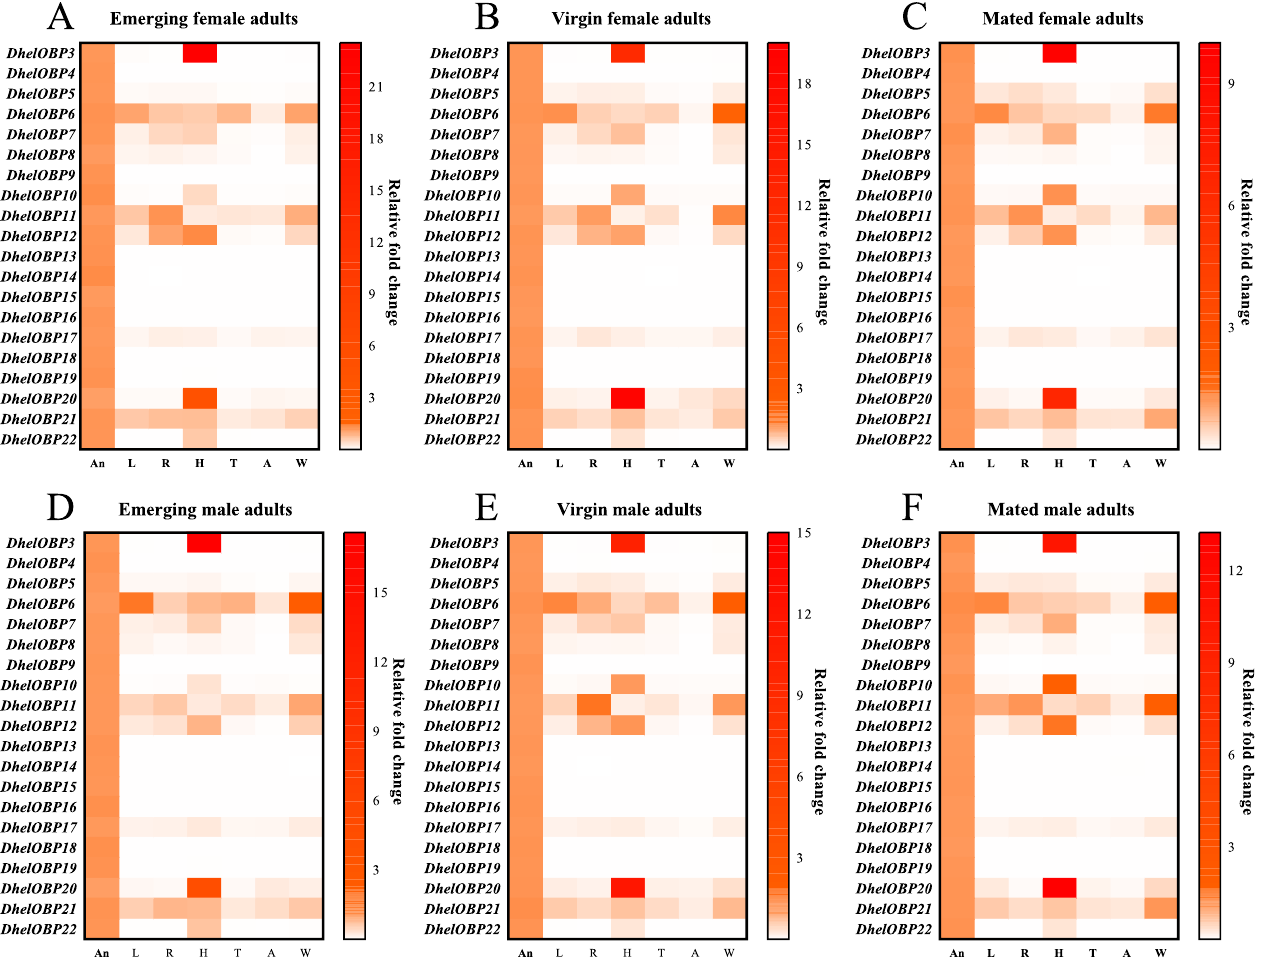
Figure 3. Heatmap of tissue expression patterns of DhelOBPs at different adult physiological states for female and male adults. Transcript levels of 20 DhelOBPs were normalized by RPS , GAPDH , and α -Tubulin genes in seven organs: antennae (An), head (H), thorax (T), abdomen (A), reproductive organ (R), leg (L), and wings (W). ( A – F ) are the expression levels of DhelOBPs in different organs at different physiological states (emerging, virgin, and mated).